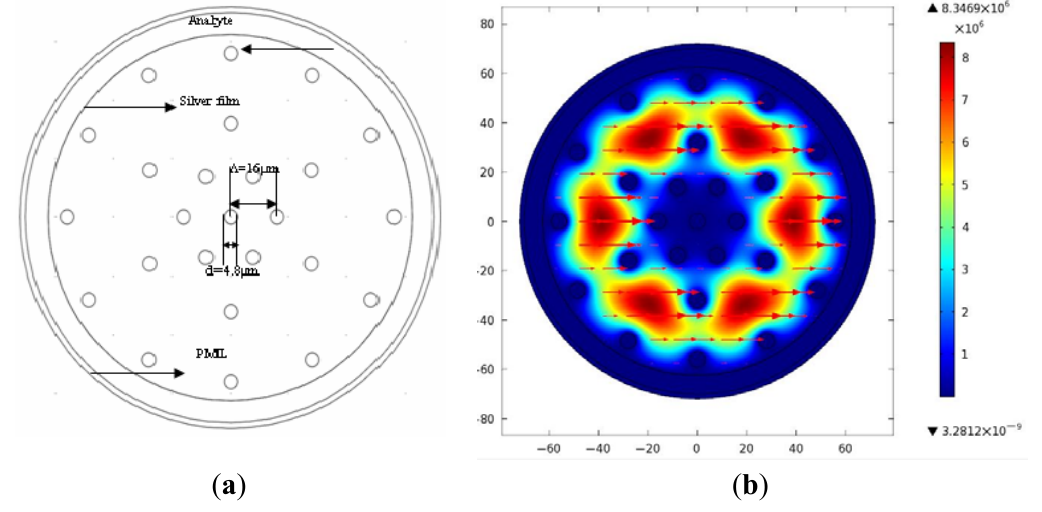
Figure 5. ( a ) the improved structure diagram of the large-mode-area plastic PCF with 125 μ m diameter and more air holes; ( b ) Optical field distribution of the fundamental